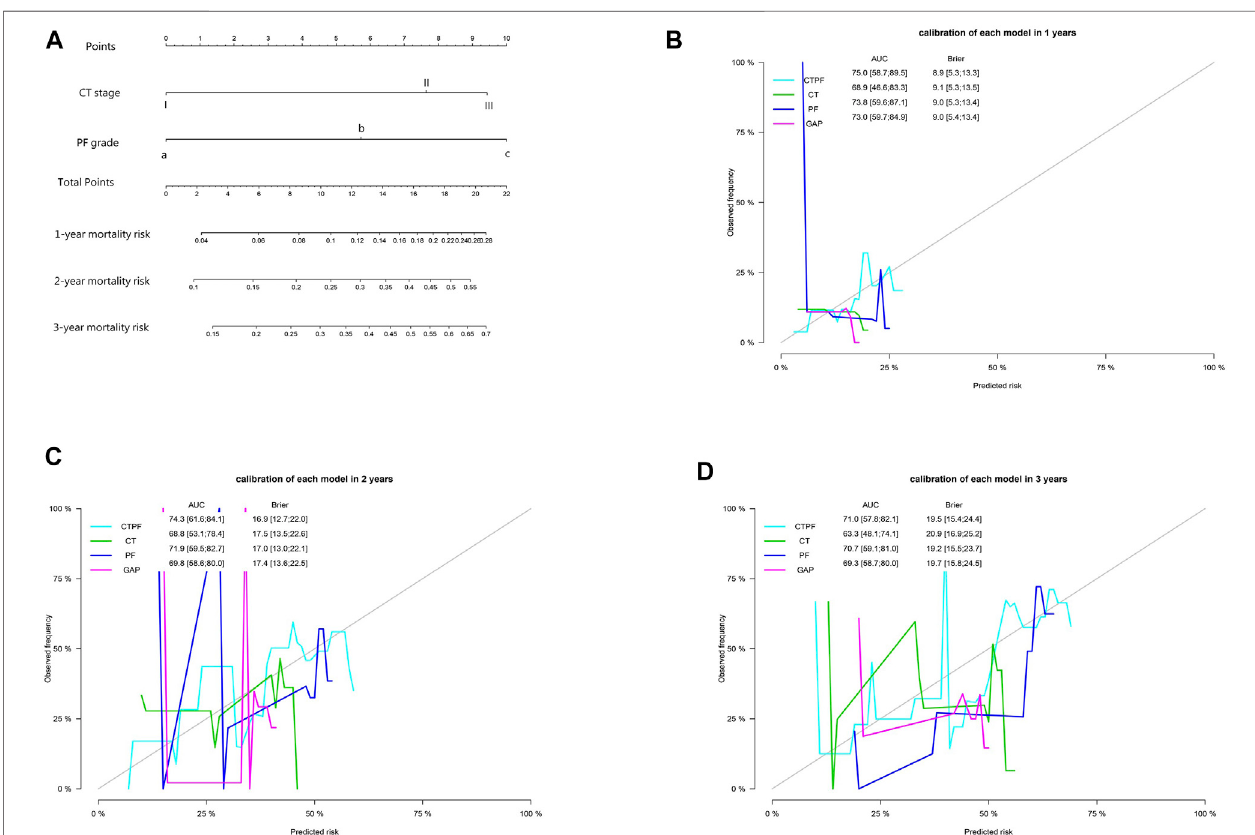
FIGURE 4 | Model prediction nomogram and calibration curve. (A) Mortality nomogram of CTPF as the predictive model. (B – D) Calibration curves after cross- validation using CT staging, PF staging, CTPF comprehensive staging, and GAP staging to predict patients ’ cumulative mortality risk at 1, 2, and 3 years. The CTPF prediction model has the best AUC value, Brier score, and stability.